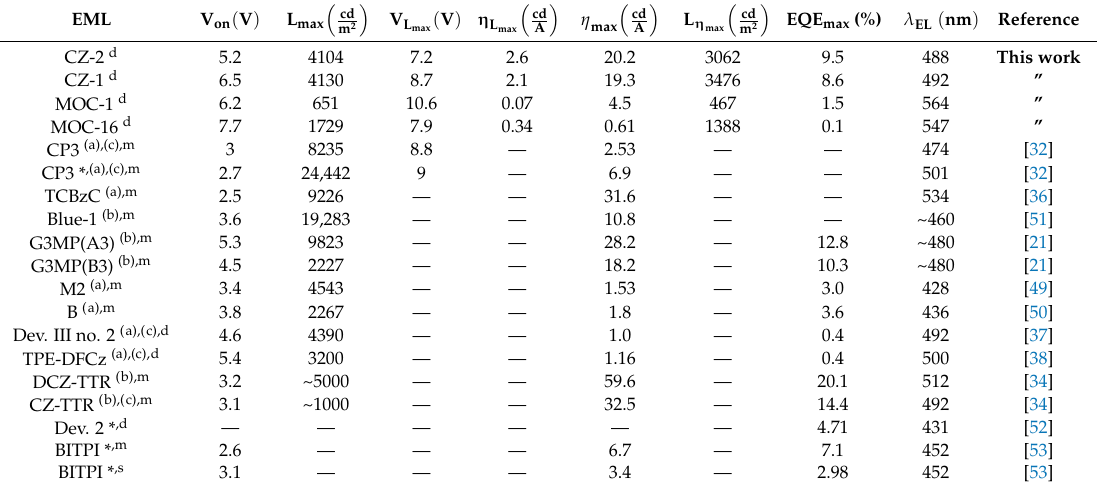
Table 2. Device performance of the four kinds of OLEDs based on carbazole and TPD derivatives as EML † . Several other devices from the literature are also